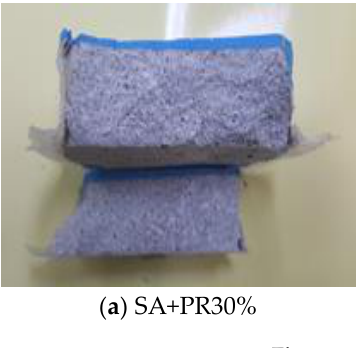
Figure 9. Test result of permeability.